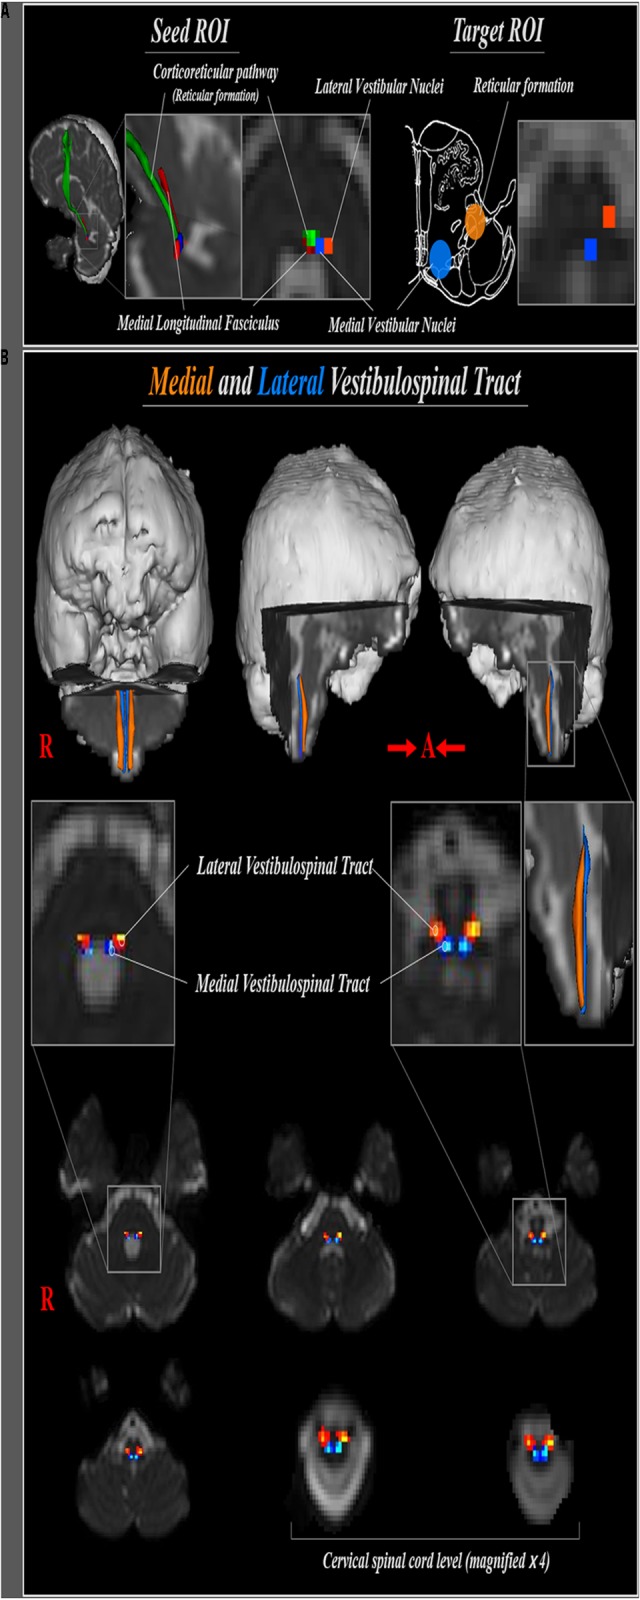
(A) Seed regions of interest (ROI) for medial and lateral vestibulospinal tract were placed on the medial (blue) and lateral (orange) vestibular nuclei at the level of pons, respectively. Target ROI for medial and lateral vestibulospinal tract were placed on the medial vestibular nuclei (blue) and reticular formation (orange), respectively. (B) The neural pathways of medial (blue) and lateral (orange) vestibulospinal tract between pontine vestibular nuclei and upper cervical spinal cord are shown at each brain level in a normal subject (a 33-year-old male).